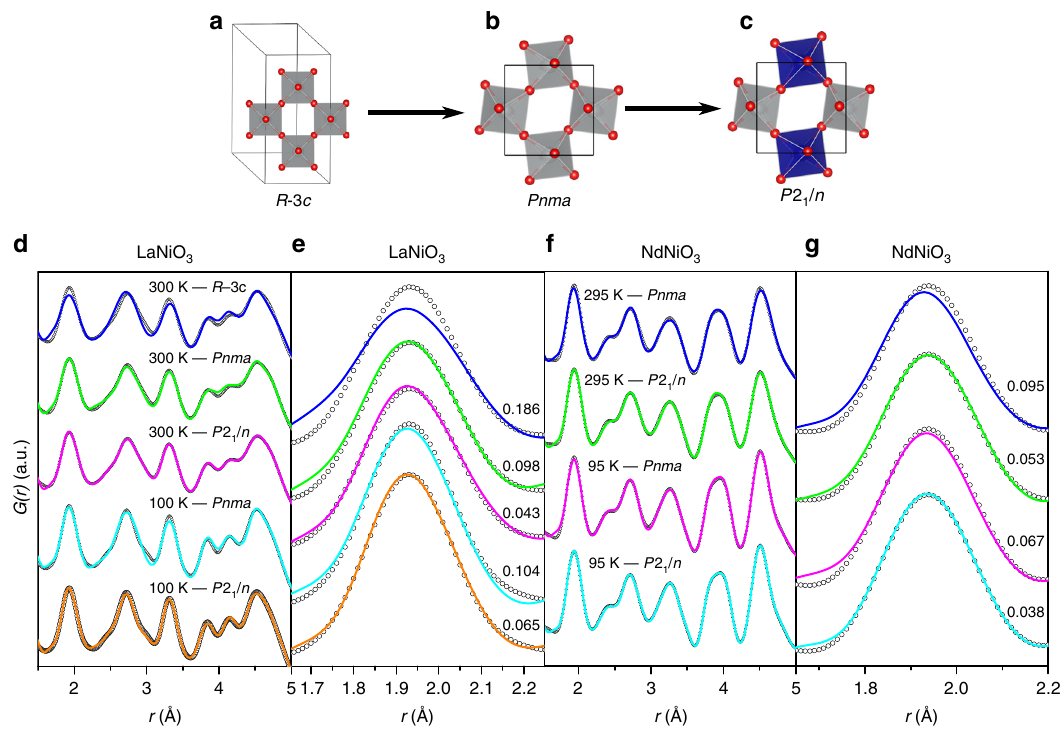
Fig. 1 Neutron pair distribution function (PDF) and structural results. a Rhombohedral structural model with a single NiO 6 octahedra (gray polyhedra). b Orthorhombic structural model with a single NiO 6 octahedra (gray polyhedra). c Monoclinic structural model with a contracted (gray polyhedra) and an expanded (blue polyhedra) NiO 6 octahedra. d Neutron PDFs for LaNiO 3 re fi ned with various structural models at 300 and 100 K. e Close-up view of re fi nements in c focusing of the fi rst peak in the PDF describing the local NiO 6 octahedra. f Neutron PDFs for NdNiO 3 re fi ned with various structural models at 295 and 95 K. g Close-up view of re fi nements in c focusing of the fi rst peak in the PDF describing the local NiO 6 octahedra. Open circles in e and f refer to the experimental PDF whereas solid lines are the re fi nement. The weighted residual (goodness-of- fi t, R w ) values for each re fi nement are shown in e and